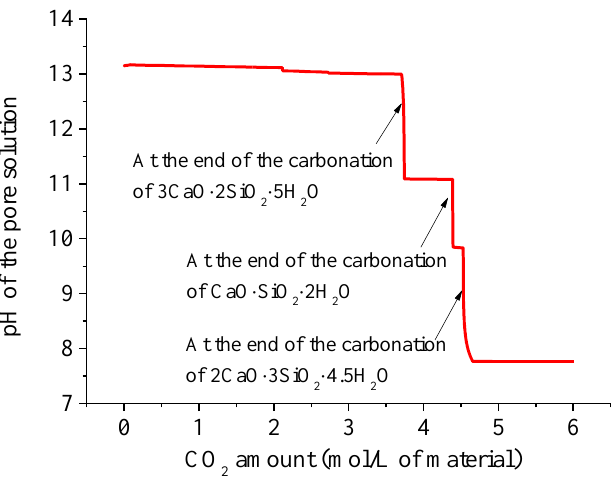
Figure 6. pH in the pore solution in air-carbonated mortar as a function of CO 2 uptake.